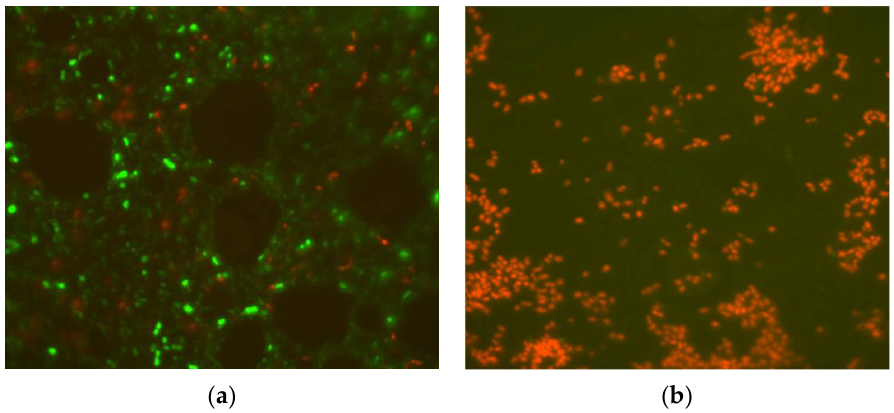
Figure 4. LIVE/DEAD Baclight test carried out with fluorescence microscopy from samples with cork functionalized with Mo Se . Biofilter without f -cork ( a ), Biofilter functionalized with f -cork ( b ). Dead cells are stained in red, while green-stained cells are alive.